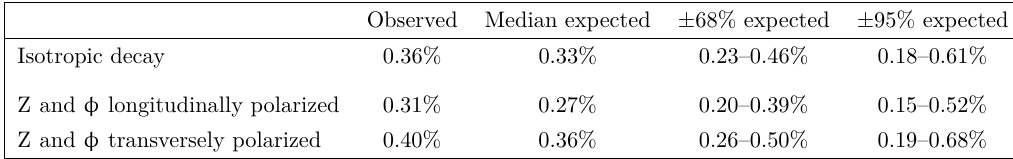
Table 4 . Observed and expected 95% CL upper limits on B (H → Z (cid:30) ) , for different polarizations. total B (H → Z (cid:26) ) and B (H → Z (cid:30) ) , the results mainly probe the indirect process via